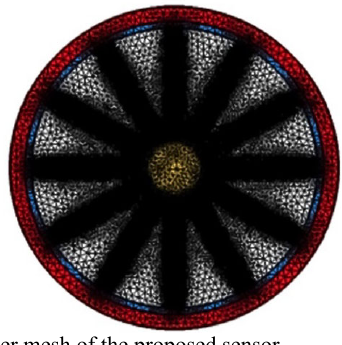
Fig. 3 Finer mesh of the proposed